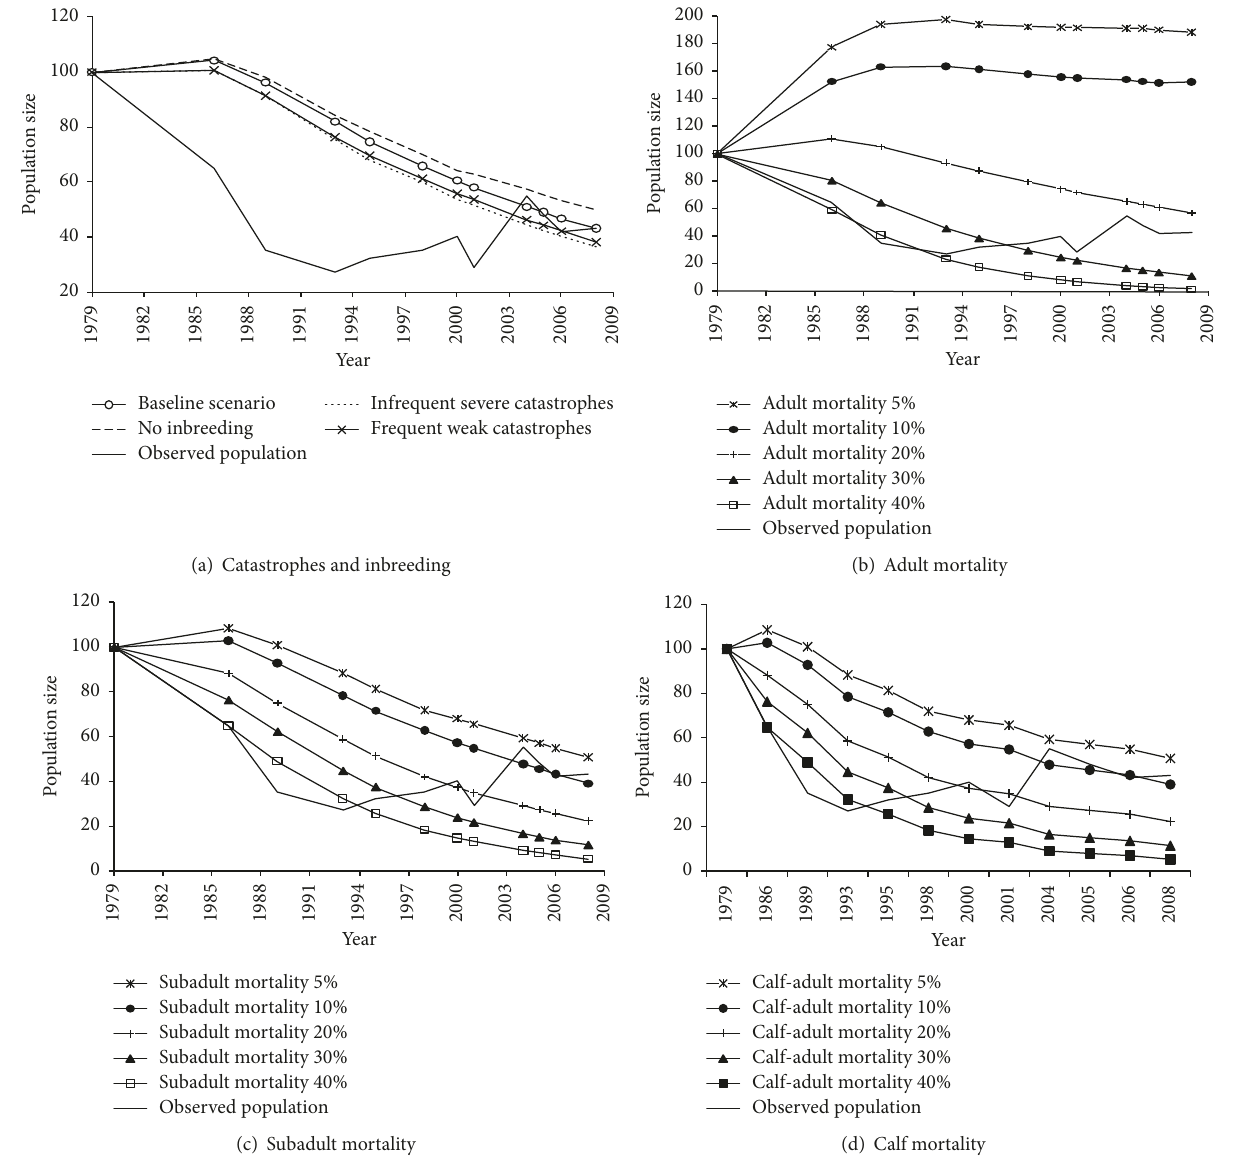
Figure 1: Comparing modelled mean population size with observed roan antelope population in RNP between 1979 and 2008.